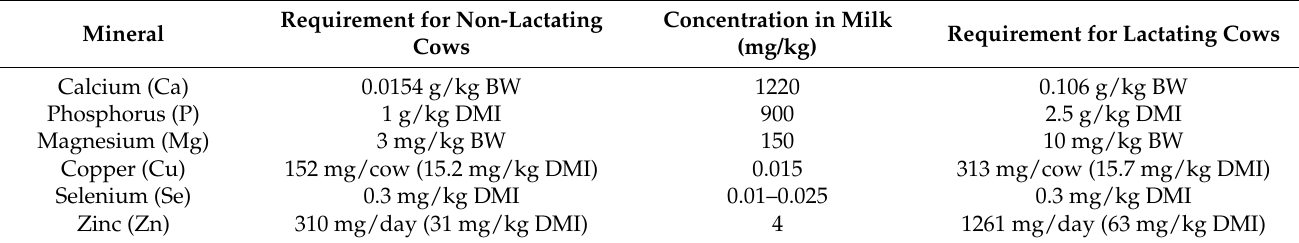
Assumptions: 650 kg body weight (BW) Holstein cow, 40 kg of milk per day if lactating, dry matter intake (DMI) in lactating/non-lactating cow equals 20/10 kg per